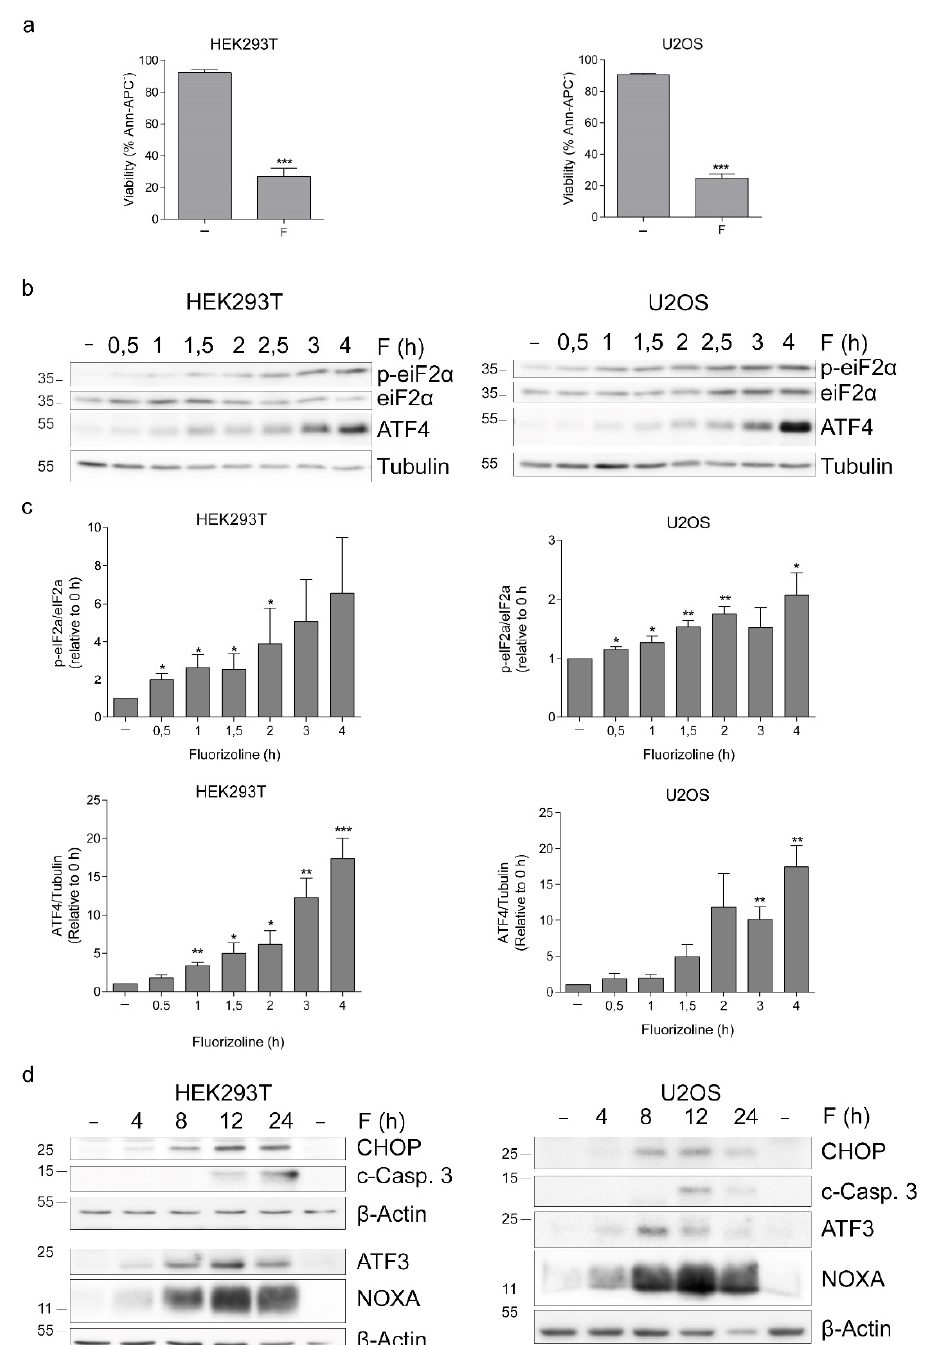
Figure 1. The ISR is activated after fluorizoline treatment in HEK293T and U2OS cells. ( a ) HEK293T and U2OS cells were treated with 15 and 20 μ M fluorizoline, respectively, for 24 h. b-d HEK293T and U2OS cells were treated with 15 and 20 μ M fluorizoline, respectively, for the indicated time. ( a ) Viability was measured by flow cytometry, and it is expressed as the mean ± SEM of the percentage of non-apoptotic cells (annexin V-negative). ( b – d ) Protein levels were analyzed by Western blot. Tubulin and β -actin were used as loading controls. Images proceeding from different gels are separated with white space. These are representative images of at least three independent experiments. ( c ) Quantification of relative p-eIF2 α /eIF2 α and ATF4/Tubulin band intensity * p < 0.05, ** p < 0.01, *** p < 0.001. Each condition vs. untreated cells ( − ) ( n = 3).